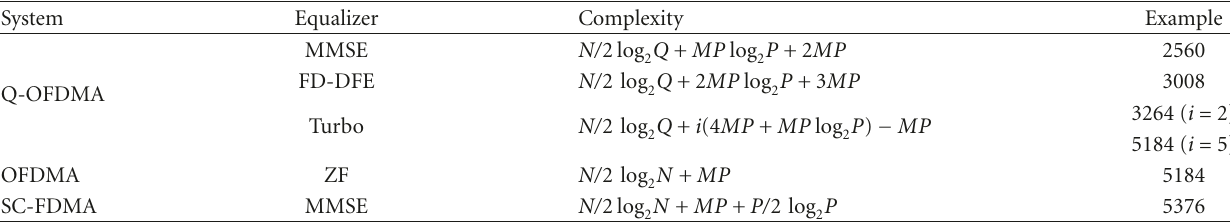
Table 1: System receiver complexity in terms of numbers of complex multiplications per frame. For the Q-OFDMA systems, the linear MMSE equalizer, FD-DFE, and turbo receiver (the complexity of the decoder is excluded, i denotes the number of the iterations) are listed for comparison. For the conventional OFDMA system, only the maximum likelihood solution, linear ZF equalizer, is compared. For SC- FDMA system, the linear MMSE equalizer, which reduces the e ff ect of the noise enhancement, is compared. For the example scenario, numerical values are for N = 1024, Q = 16, P = 64, and M =